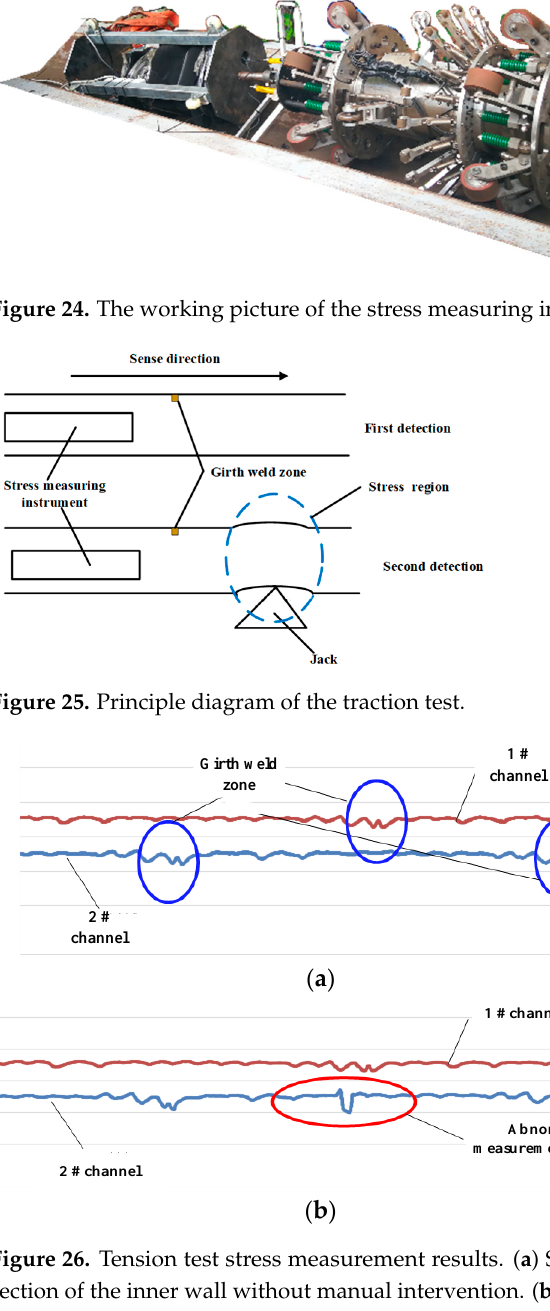
Figure 24. The working picture of the stress measuring instrument.